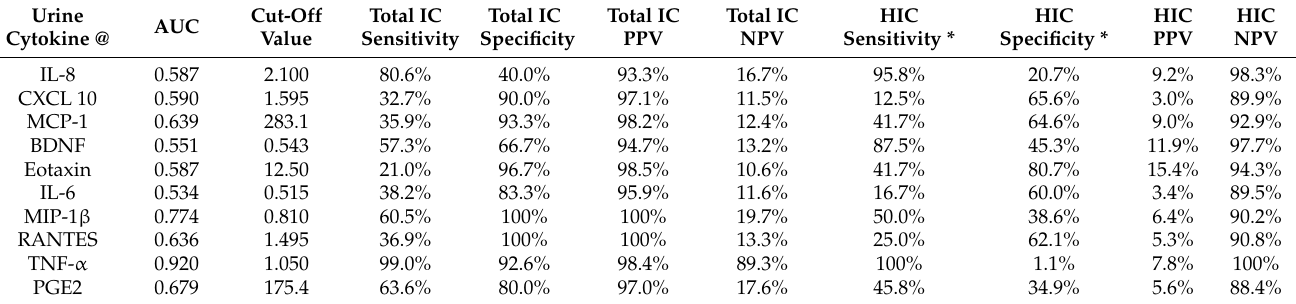
Table 4. The receiver operating characteristics of urine biomarkers in diagnosis of IC/BPS patients and Hunner’s IC